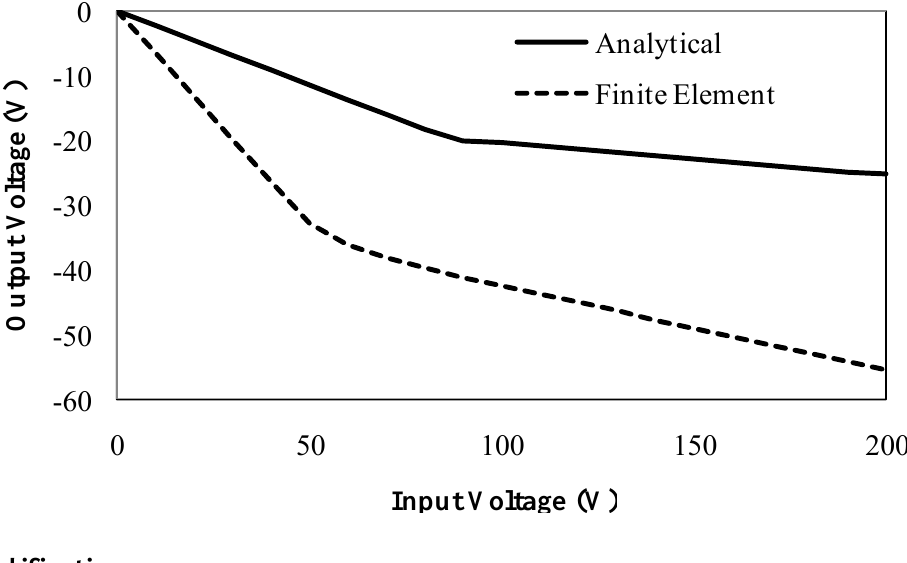
Figure 5. Comparison of induced voltages generated analytically and from finite element models using a bilinear hardening relationship for